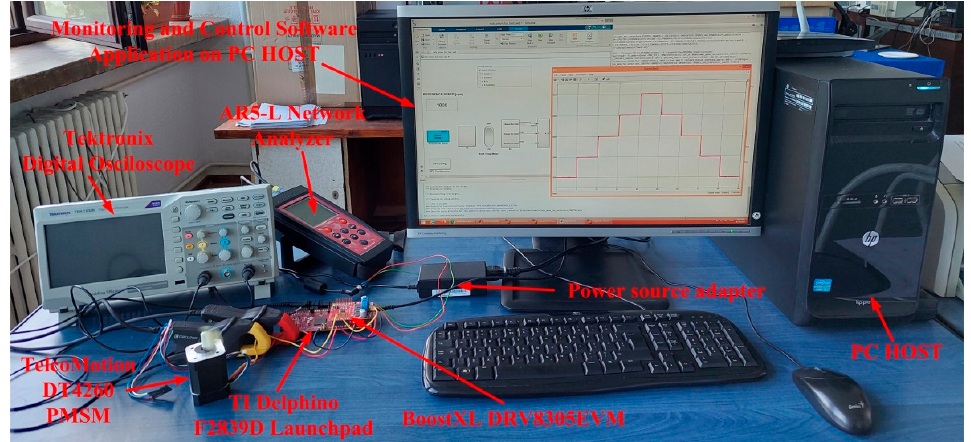
Figure 48. Experimental image for testing the PMSM sensorless control system.